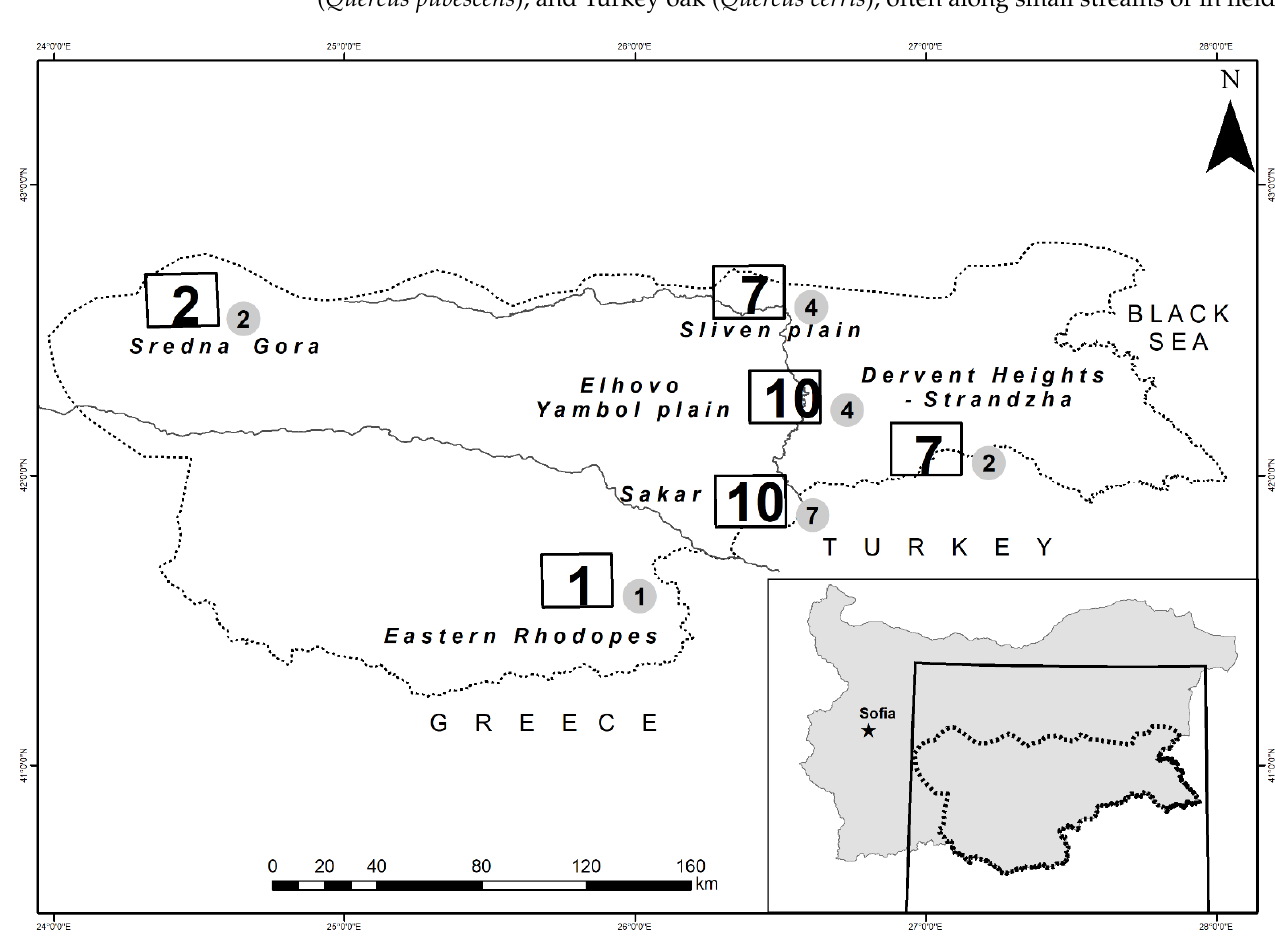
Figure 1. Number of sampled breeding territories of the eastern imperial eagle (in a square) vs. number of sampled souslik plots (in circle) in the different regions (Eastern Rhodope Mnt., ER; Sredna Gora Mnt., SG; Sliven plain, SP; Elhovo-Yambol plain, EYP; Dervent Heights-Western foothills of Strandzha Mnt., DHWstr; Sakar Mnt.).